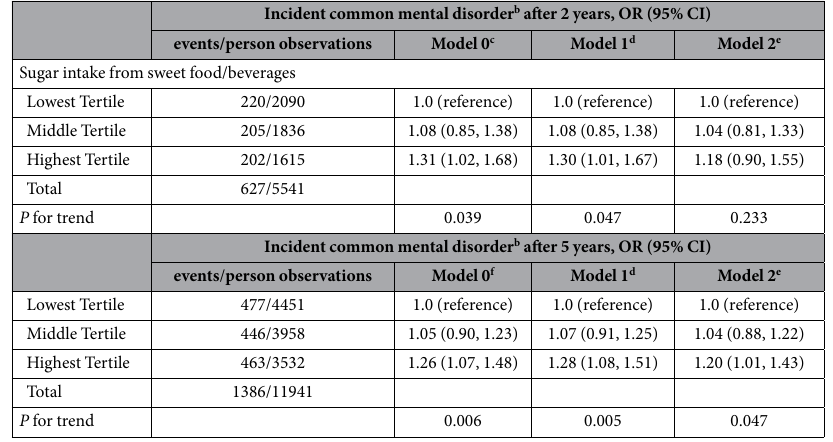
Table 3. Prospective association of sugar intake from sweet food/beverages and incident common mental disorder after 2 and 5 years in men a . Abbreviations: OR = Odds ratio, CI = Confidence interval, DASH = Dietary Approaches to Stop Hypertension. a Prospective association across phases 3, 5 for 2-year and 3, 5, 7, 9 for 5-year incident common mental disorder. b Common mental disorder measured using the 30-item General Health Questionnaire. c 2-year model 0 (655 events/5767 person observations): adjusted for age and ethnicity. d Model 1: additionally adjusted for marital status, last grade level in civil service, smoking, alcohol intake, physical activity, sleep duration. e Model 2: additionally adjusted for energy intake from other foods, modified DASH diet score, fish, coffee and tea intake. f 5-year model 0 (1448 events/12445 person observations): adjusted for age and